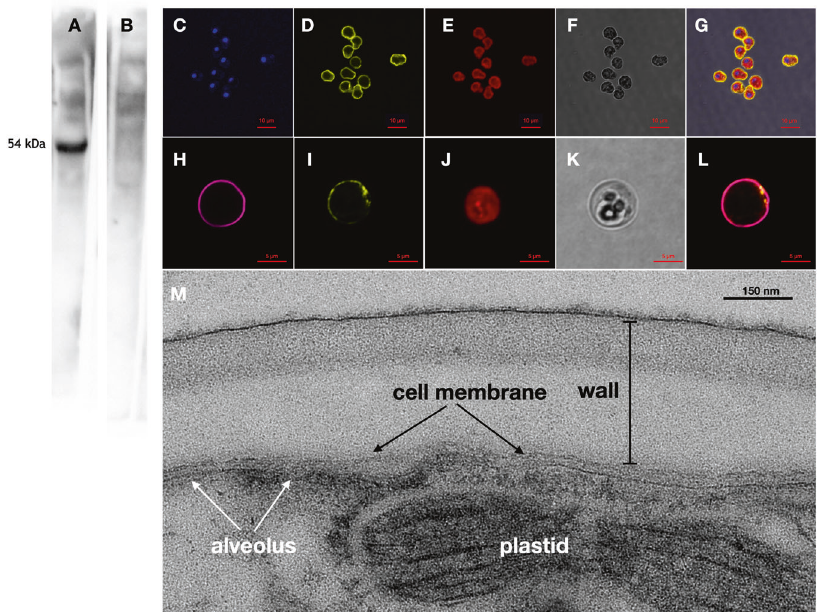
Fig. 2 Western blot and immuno fl uorescence localisation of Bm SWEET1 to the cell membrane in B. minutum . A The peptide antiserum labels a single band of molecular mass 56 kDa in cultured cells. B labelling is abrogated by preincubation of the serum with the antigenic peptide. C Ten cultured B. minutum cells labelled with DAPI in blue. D Bm SWEET1 antiserum in yellow. E Chlorophyll auto fl uorescence in red. F Bright fi eld illumination. G Merge of all, showing Bm SWEET1 at the periphery of the cells and not associated with the nuclei or the plastids. H Close up of a single cultured B. minutum cell stained with calco fl uor for cellulose in magenta. I Same cell as H labelled for Bm SWEET1 in yellow, J Same cell as H showing chlorophyll auto fl uorescence in red. K Same cell as H in bright fi eld illumination. L Merge of calco fl uor and Bm SWEET1 showing the Bm SWEET1 protein mostly subtending the cellulose wall. M Electron micrograph of a B. minutum cell depicting the cell membrane situated just underneath the cell